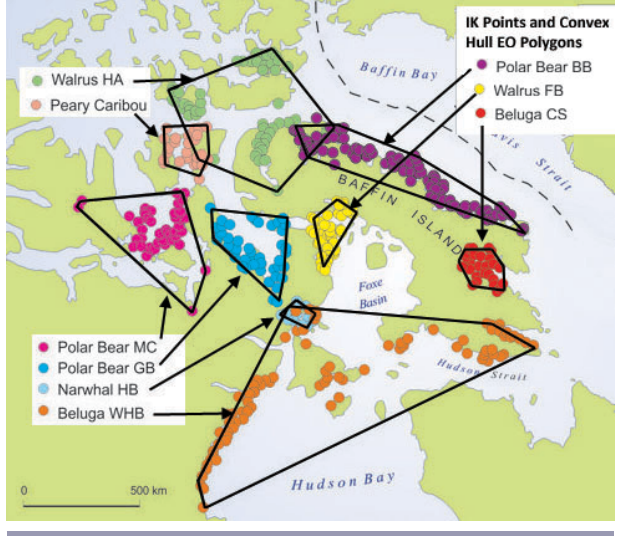
Fig. 3 . Inuit knowledge (IK) extent of occurrence (EO) convex hull polygons for nine designated units.